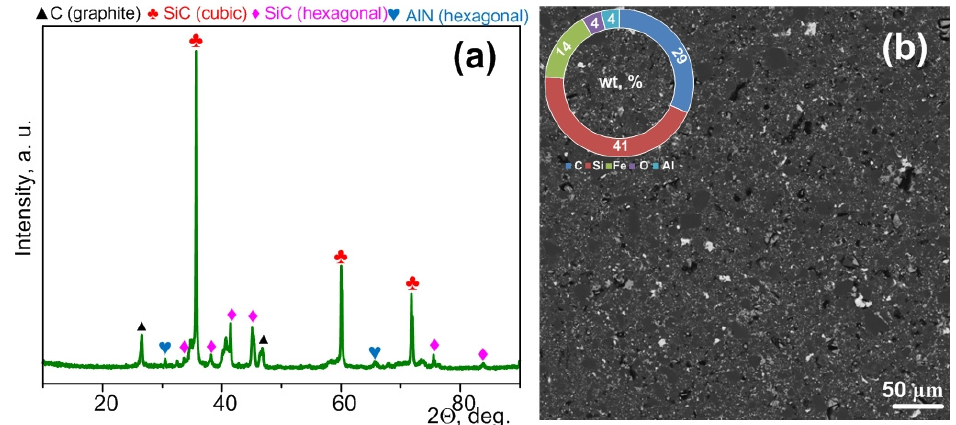
Figure 6. XRD pattern of the bulk ceramic sample sintered from silicon carbide-based micropowder by spark plasma sintering ( a ), SEM image of a section of the sintered sample surface and data of the EDS analysis ( b ).